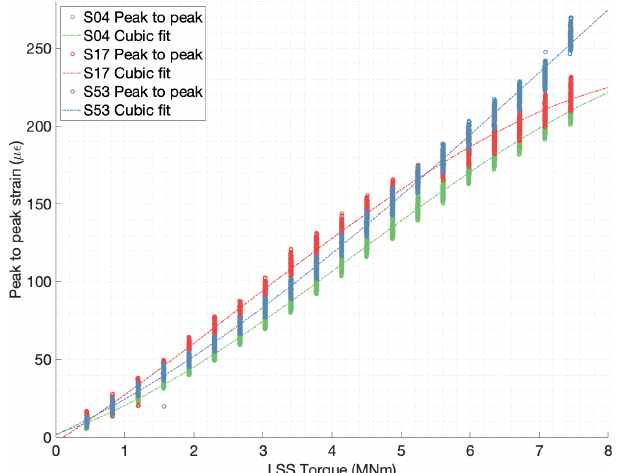
Figure 6. Sensor S01 strain signal (left axis) during a single revo- lution of the input shaft (right axis) with detected peaks.